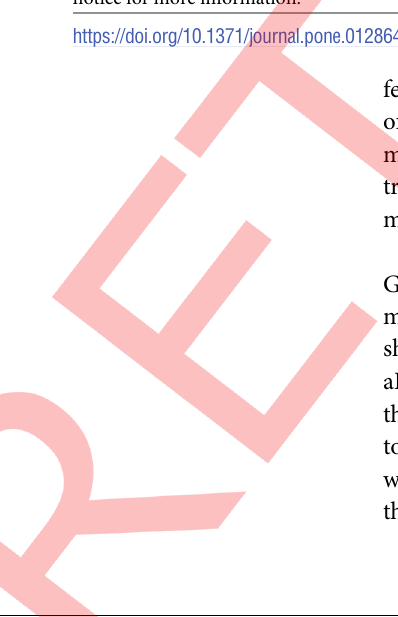
Fig 6. Effect of induction of HO-1 (CoPP) and inhibition of HO (SnMP) in mice fed a high fructose diet for 8 weeks on western blot and densitometry analysis. (A) insulin receptor- β . (B) Insulin receptor phosphorylated at tyrosine 1146. (C) pAKT/AKT levels. (D) G6Pase. (E) FAS and (F) aP2 expression. Data are shown as mean band density normalized to β -actin. Results are mean ± SE, n = 4/group. � p < 0.05 vs CTR; # p < 0.05 vs HFr, + p < 0.05 vs HFr+CoPP. Fig 6A, B, D-F Actin panels, Fig 6D G6Pase panel, and Fig 6E FAS panel are excluded from this article’s CC-BY license. See the accompanying retraction notice for more